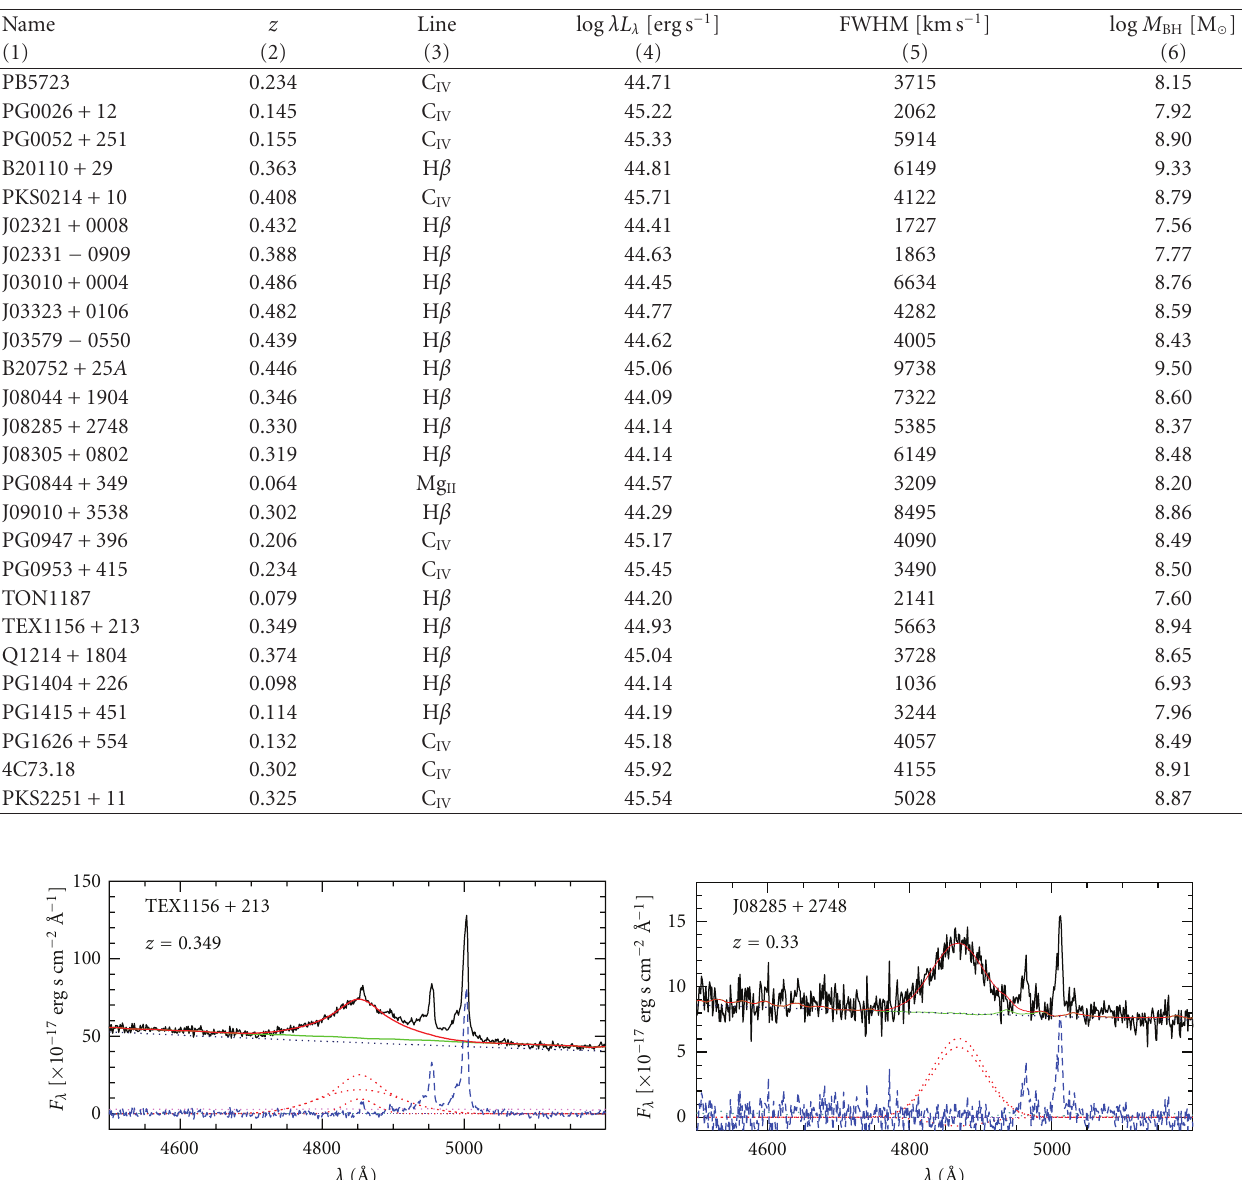
Table 2: Results from the spectroscopic analysis. (1) Quasar name. (2) Redshift. (3) Line used in the M BH estimate. (4) Continuum monochromatic luminosity at 1350 (for C IV ), 3000 (for Mg II ) or 5100 ˚A (for H β ), in ergs − 1 . (5) Line FWHM in kms − 1 . (6) Virial estimate of the black hole mass, in solar units.